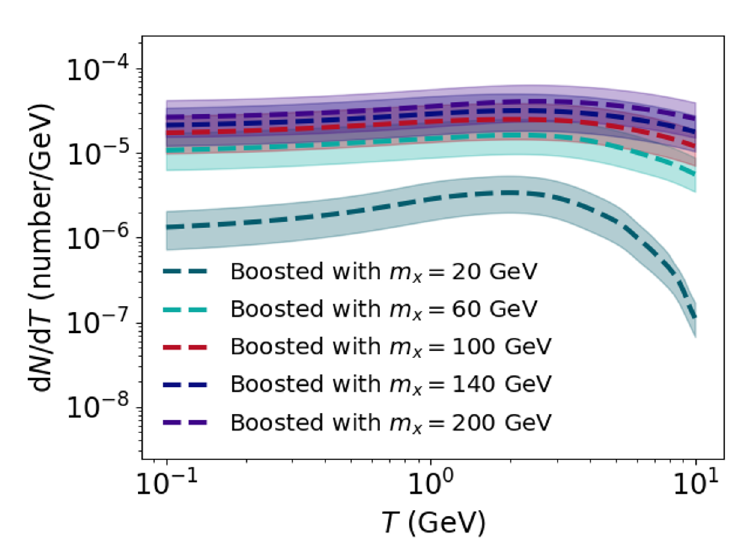
JHEP05(2020)081